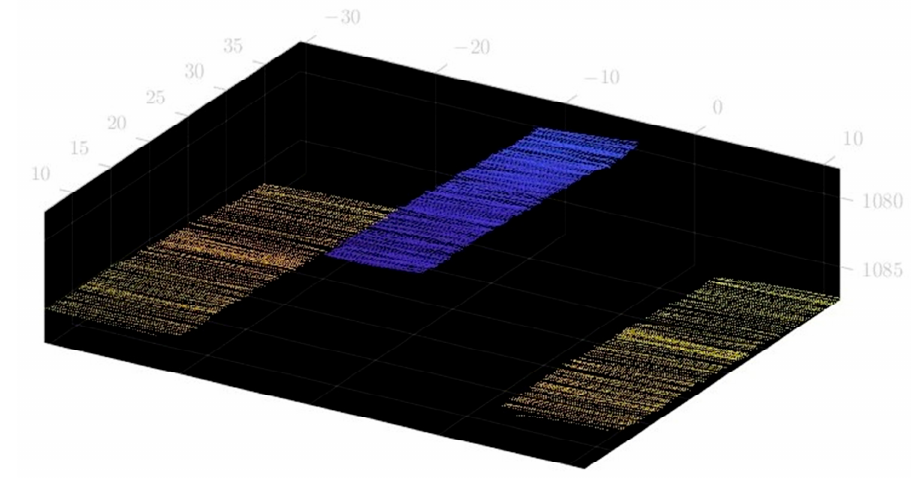
Figure 18. Point cloud image of a gauge block.